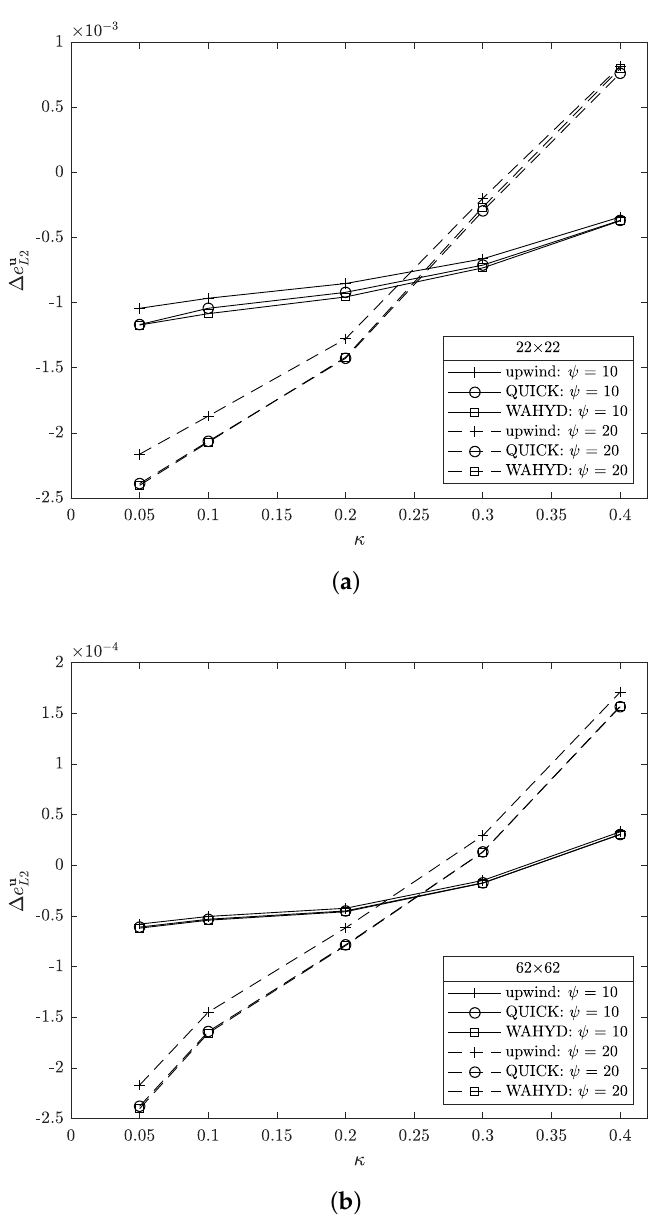
Figure 21. Velocity L 2 error norm difference as function of κ parameter and ψ , for the flow on inclined channel case. ( a ) 22 × 22 grid; ( b ) 62 ×